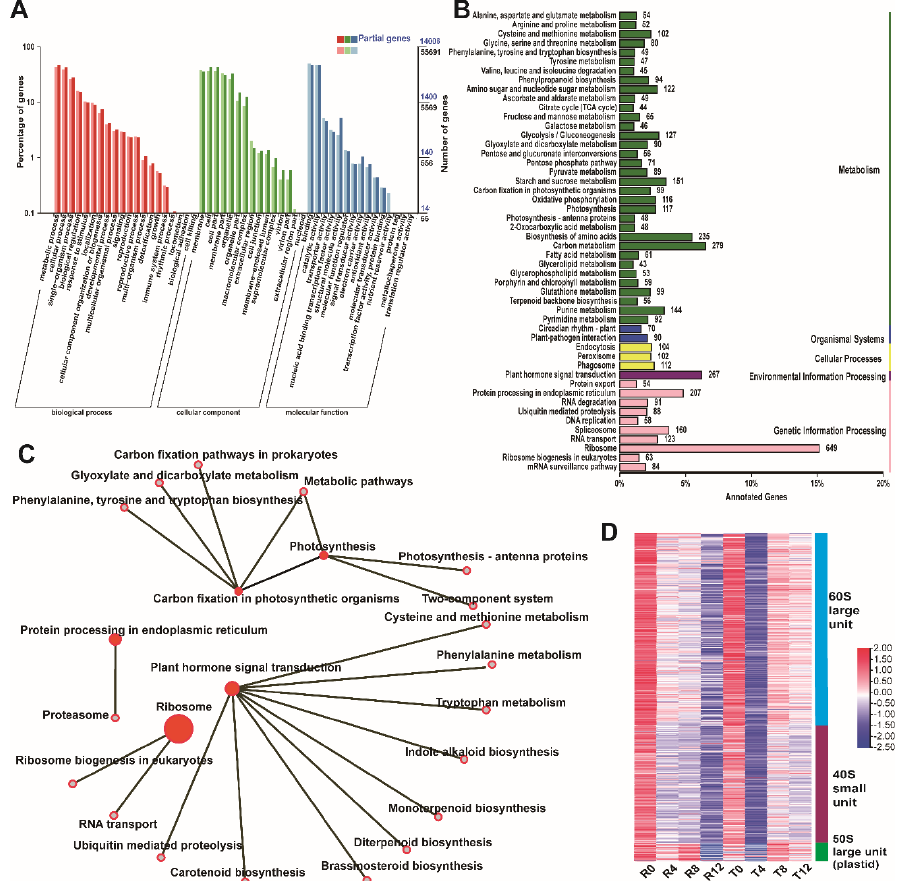
Figure 2. Analysis of all the DEGs. ( A ) GO enrichment analysis; ( B ) KEGG pathway enrichment analysis; ( C ) relationship between the KEGG pathways; ( D ) expression profile of the differentially expressed ribosomal protein